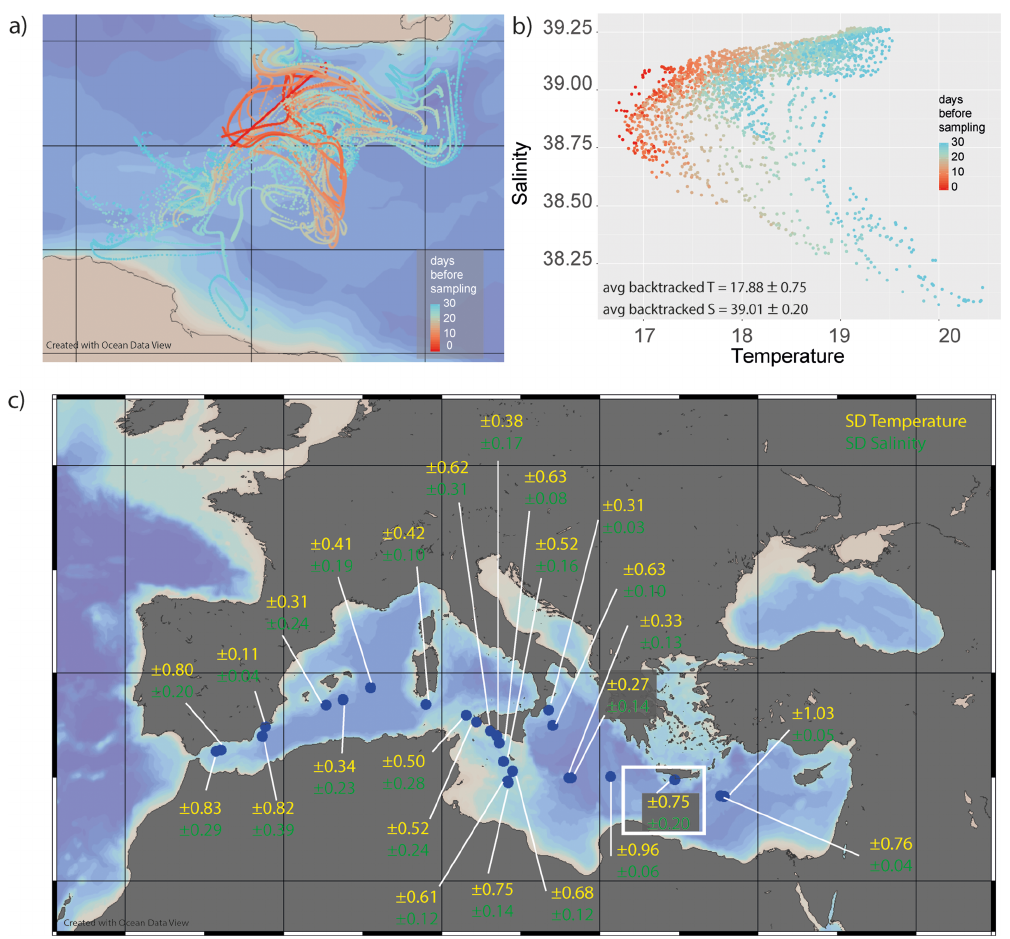
Figure 7. (a) Example of backtracked pathways for a single transect (the area marked using a white rectangle in panel c ). The colour indicates the time before sampling up to 30d. (b) Analysing the different environmental conditions at the different locations of these potential paths shows that the foraminifera sampled very likely experienced a large range of temperatures and salinities. (c) The variability in the potential environmental conditions experienced changes considerably from location to location, as indicated by notation of 1 standard deviation for both parameters for each sampling location. The maps in panels (a) and (c) were generated using Ocean Data View version